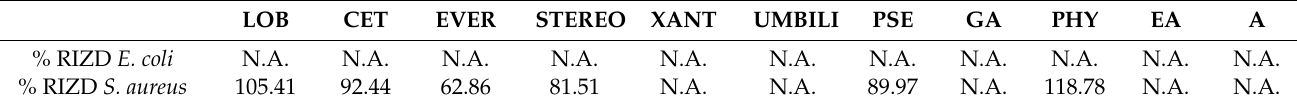
Table 4. Antibacterial activity of tested extracts and secondary